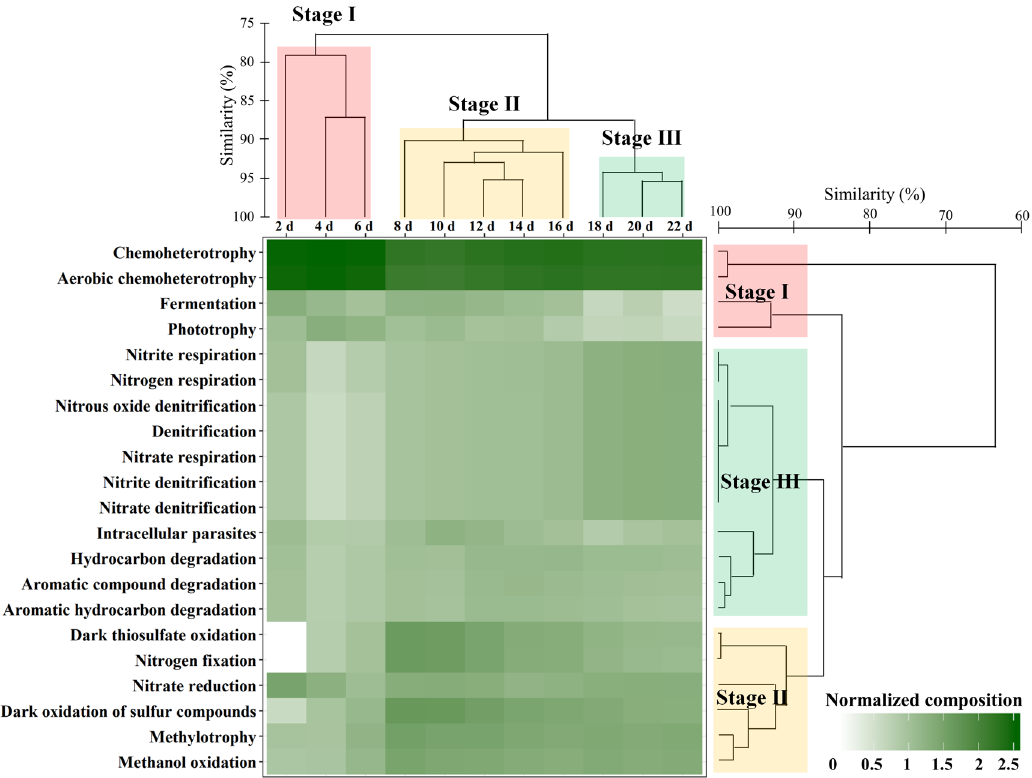
Figure 5. The time-series heatmap showing the metabolic functions during the changes in bacterial community composition using functional annotation analysis of the prokaryotic taxa (FAPROTAX). The heatmap displays the fourth root-normalized data of the bacterial read counts. The time series and functional groups of the bacterial operational taxonomic units are clustered using the Bray–Curtis similarity method. This figure was generated with RStudio v.1.2.5042 (https:// rstud io.